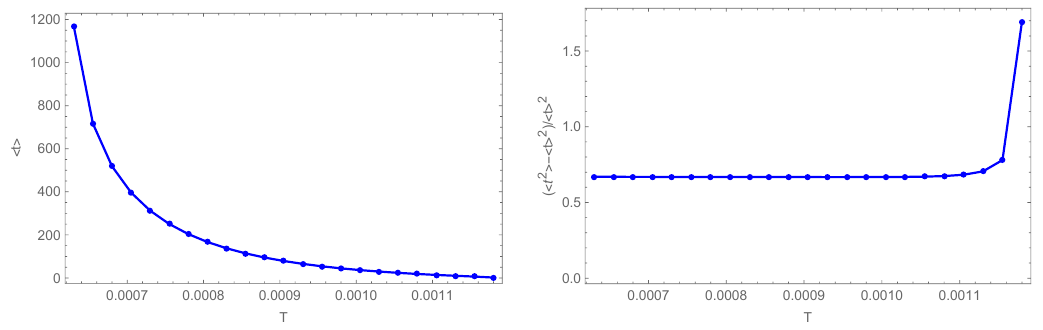
Figure 8 . Mean first passage time (left panel) and the relative fluctuation (right panel) of the transition process from the stable wormhole phase to the unstable wormhole phase. In this plot, q = 50 , J = 1 , and ˆ µ = 0 . 1